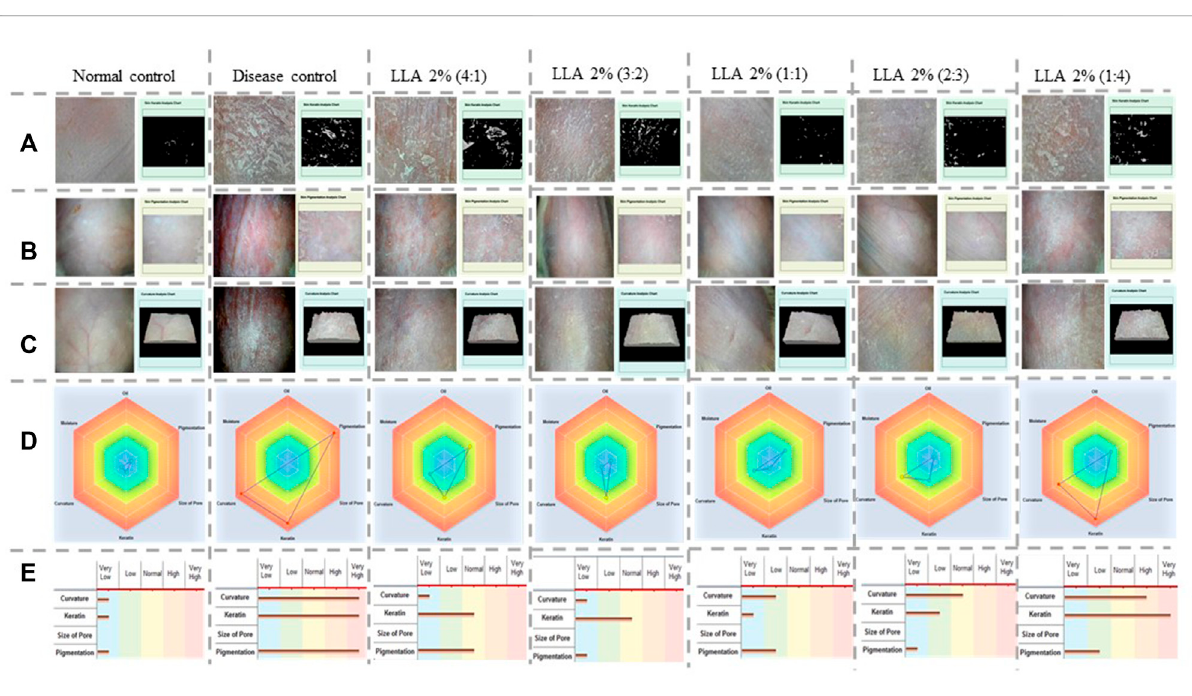
FIGURE 2 Pictorial representation of keratin, pigmentation, curvature analysis charts, radar, and bar graphs showing the severity of skin in fl ammation in different tested groups, Vertical columns present the different treatment groups, and horizontal rows denote (A) the keratin analysis chart, (B) the pigmentation analysis chart, (C) the curvature analysis chart, (D) the radar graph, and (E) bar graphs of the psoriatic and animals treated with linalool and linalyl acetate.